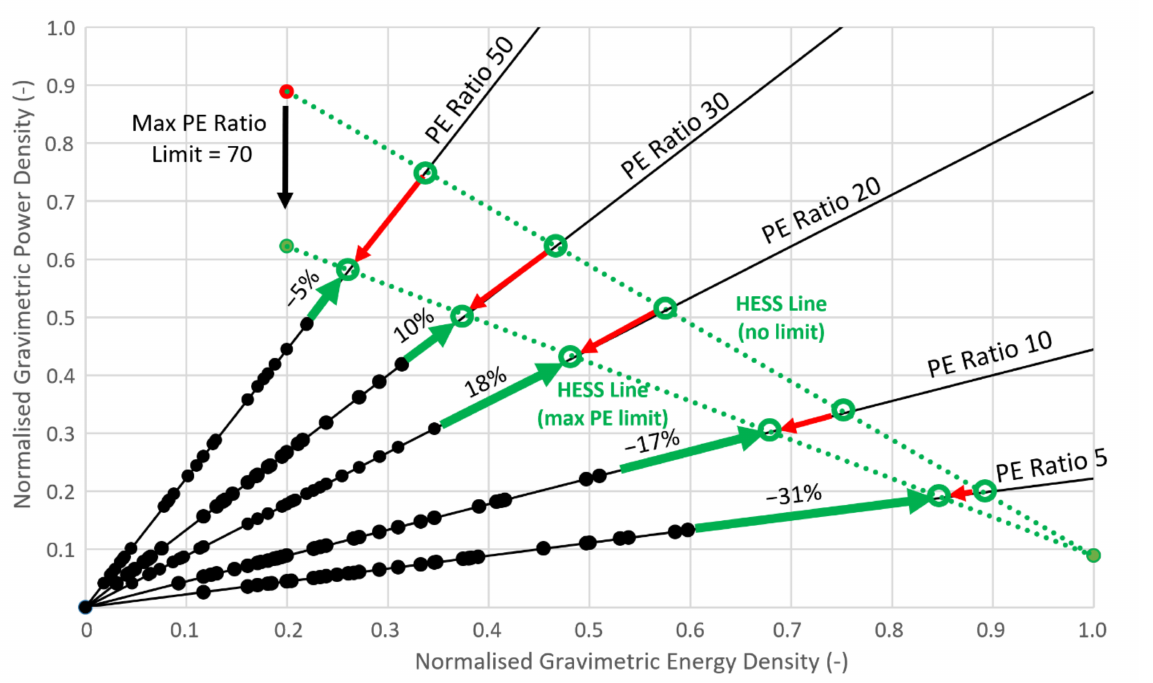
Figure 12. Ragone plot of the ‘actual’ weight-saving HESS analysis method considering a maximum PE ratio limit of